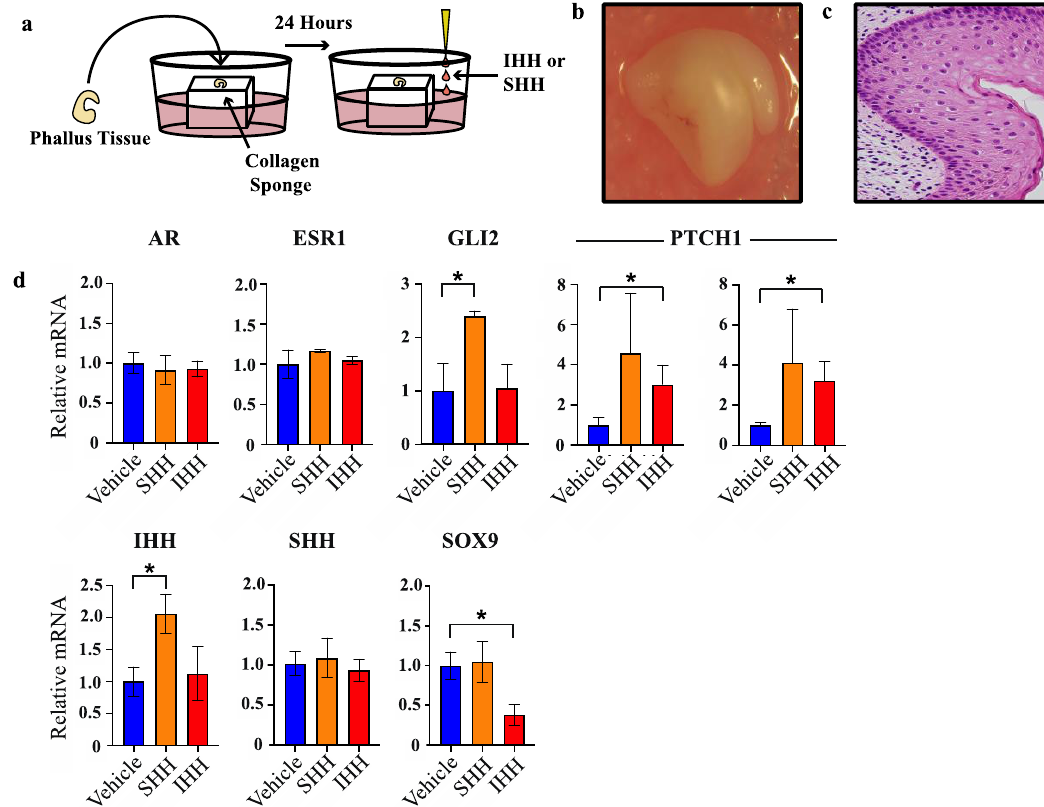
Figure 3. SHH and IHH elicit different transcriptional responses in phallus explant culture. ( a